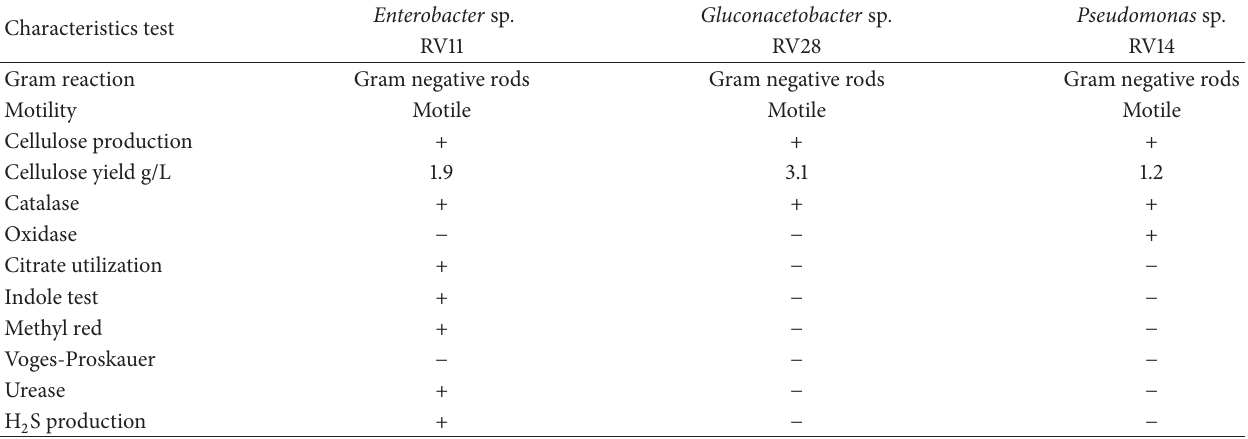
Table 1: Biochemical characterization for the isolates.